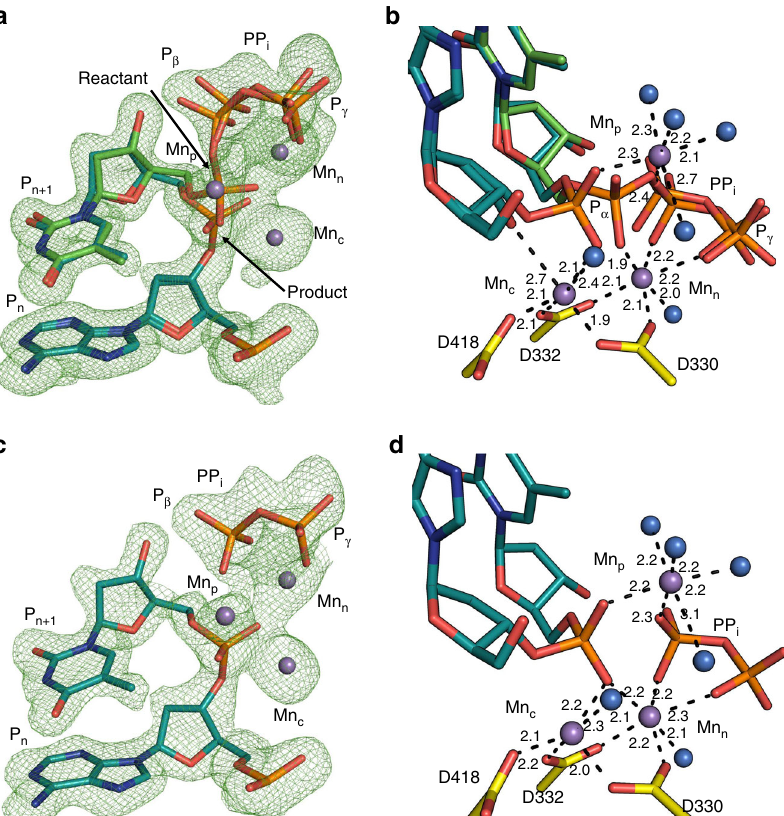
Fig. 5 Manganese-mediated insertion. Soaking of the Ca 2+ -bound pre-catalytic GS ternary complex in a cryo-solution containing 10 mM MnCl 2 initiates the reaction in the crystal. Crystals were frozen after incubation for the indicated times in the cryo-solution. a , b Reaction state (RS) at 7.5 min, c , d product state (PS) at 15 min. The panels on the left ( a , c ) display density for the bond, indicating the degree of completion of the reaction. The panels on the right ( b , d ) are close-up views of a 90° rotation of the active site with coordinating ligands indicated by dashes and distances (Å) labeled. The incoming and incorporated nucleotides are in cyan and green stick representation, respectively, while the protein side chains are in yellow . Mn 2+ ions are displayed as purple spheres and water molecules as blue spheres . The F o – F c omit map ( green ) shown is countered at 2.5